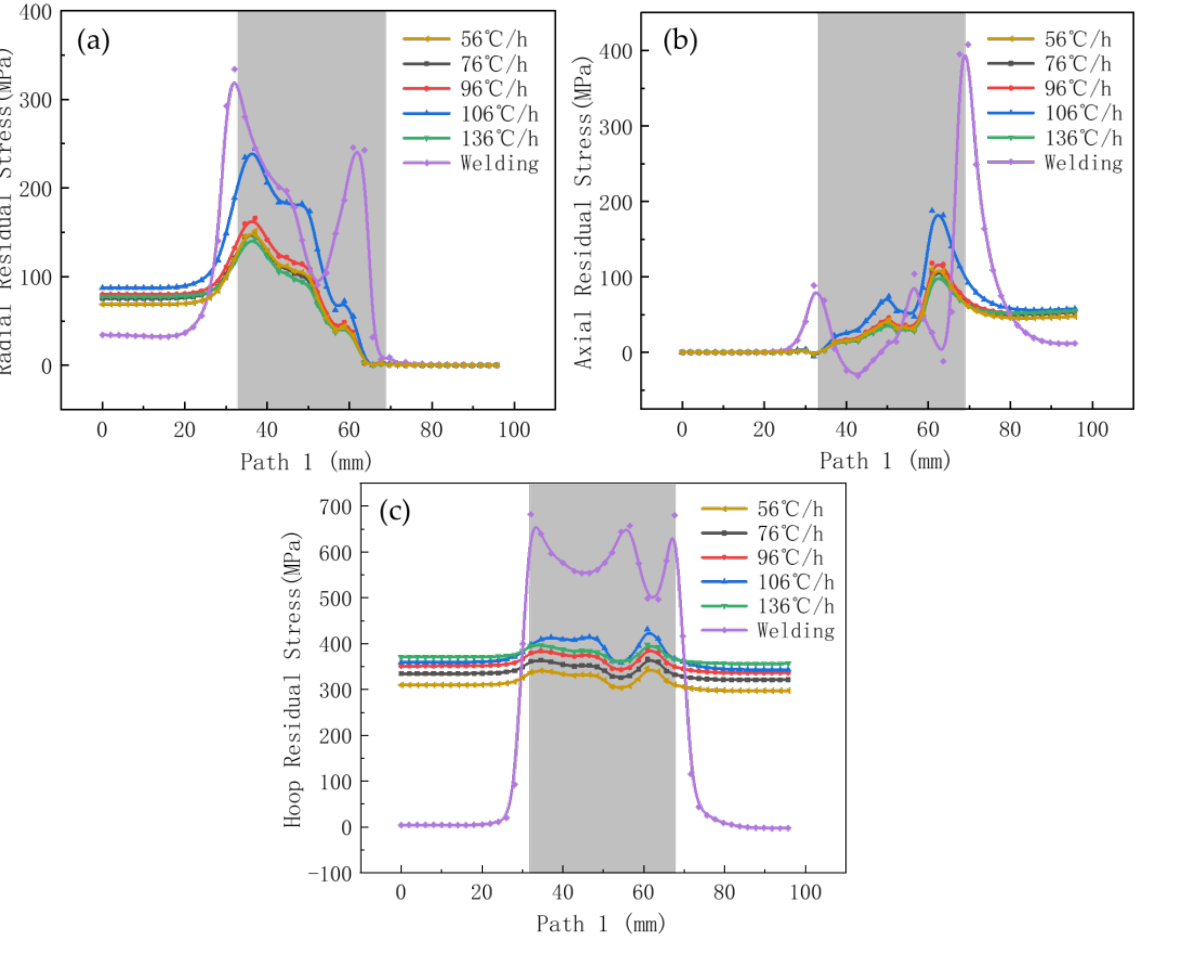
Figure 13. Effect of PWHT heating rate on the residual stress distribution of path 1: ( a ) radial, ( b ) axial, ( c ) hoop residual stress.